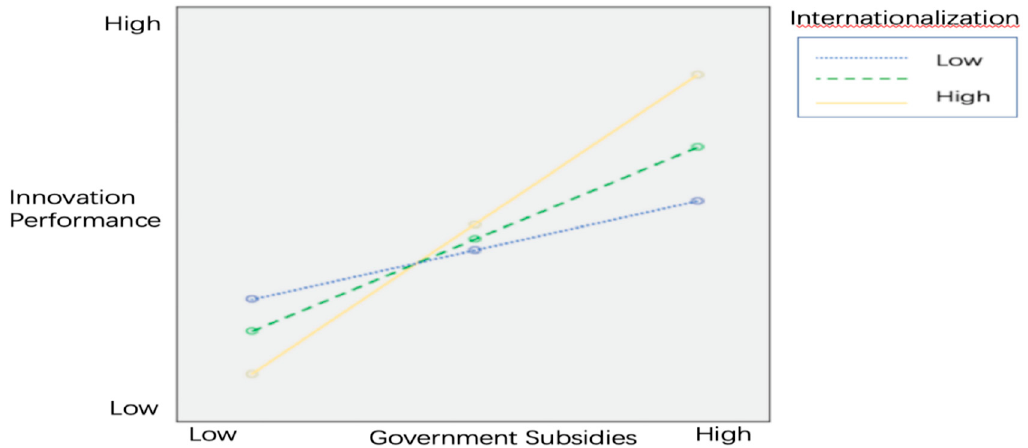
Figure 4. Interaction between government subsidies and internationalization.